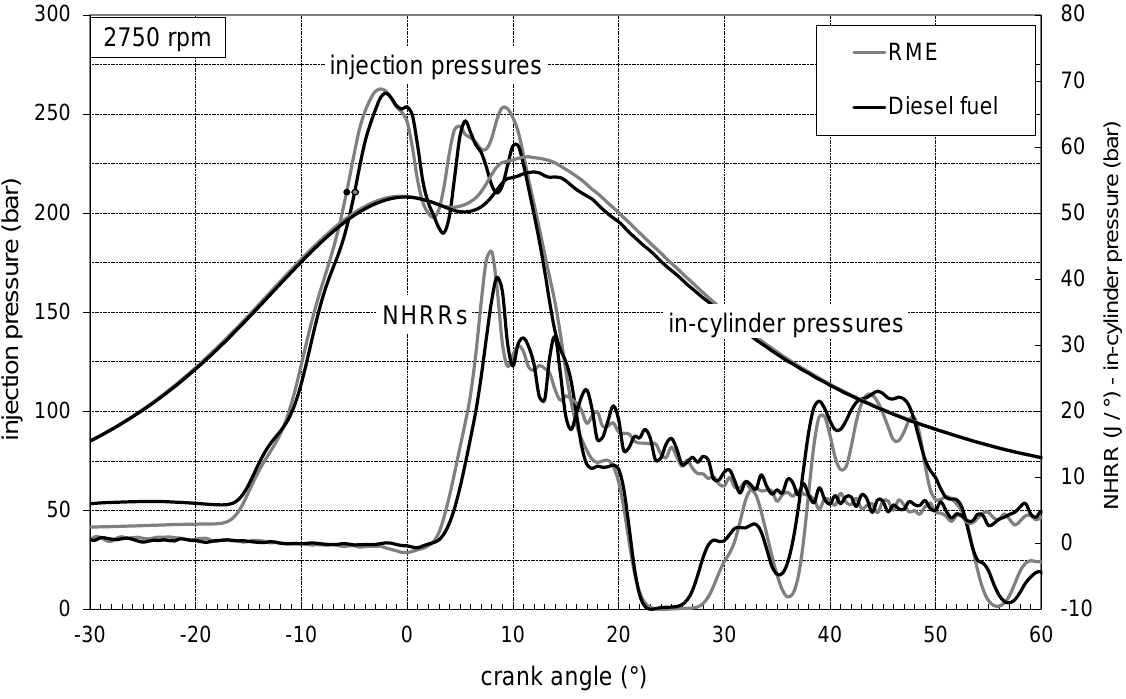
Figure 9. RME and diesel fuel injection pressures, in-cylinder pressures, and NHRR at 2500 rpm and at full load.